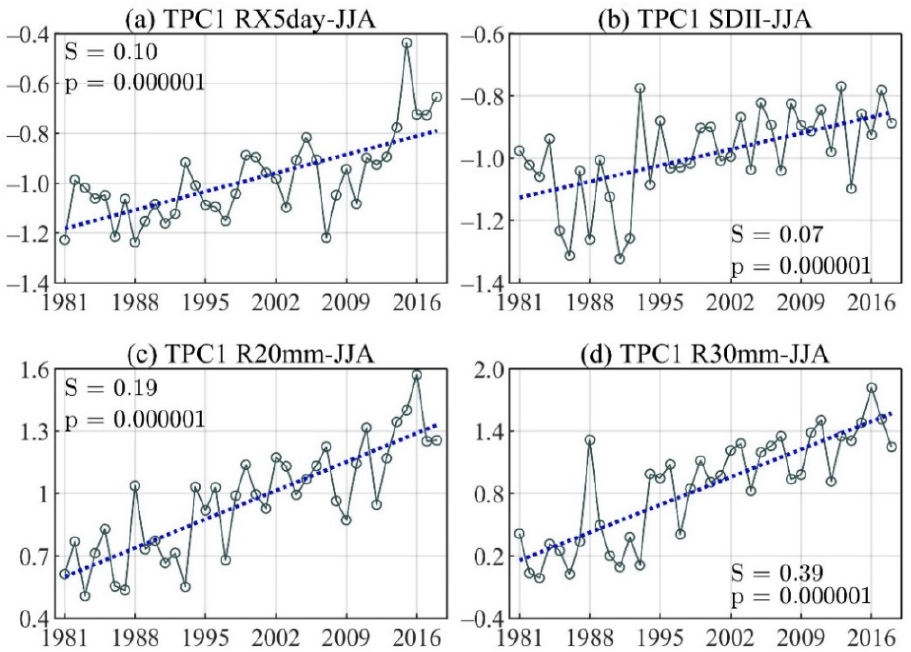
Figure 7. The linear trend of the principal component time series for the first TEOF mode of ( a ) Max 5-day precipitation amount (RX5day), ( b ) Simple daily intensity index (SDII), ( c ) Number of days with precipitations above R20mm (R20mm), and ( d ) Number of days with precipitations above R30mm (R30mm) during the July–August (JJA) season.